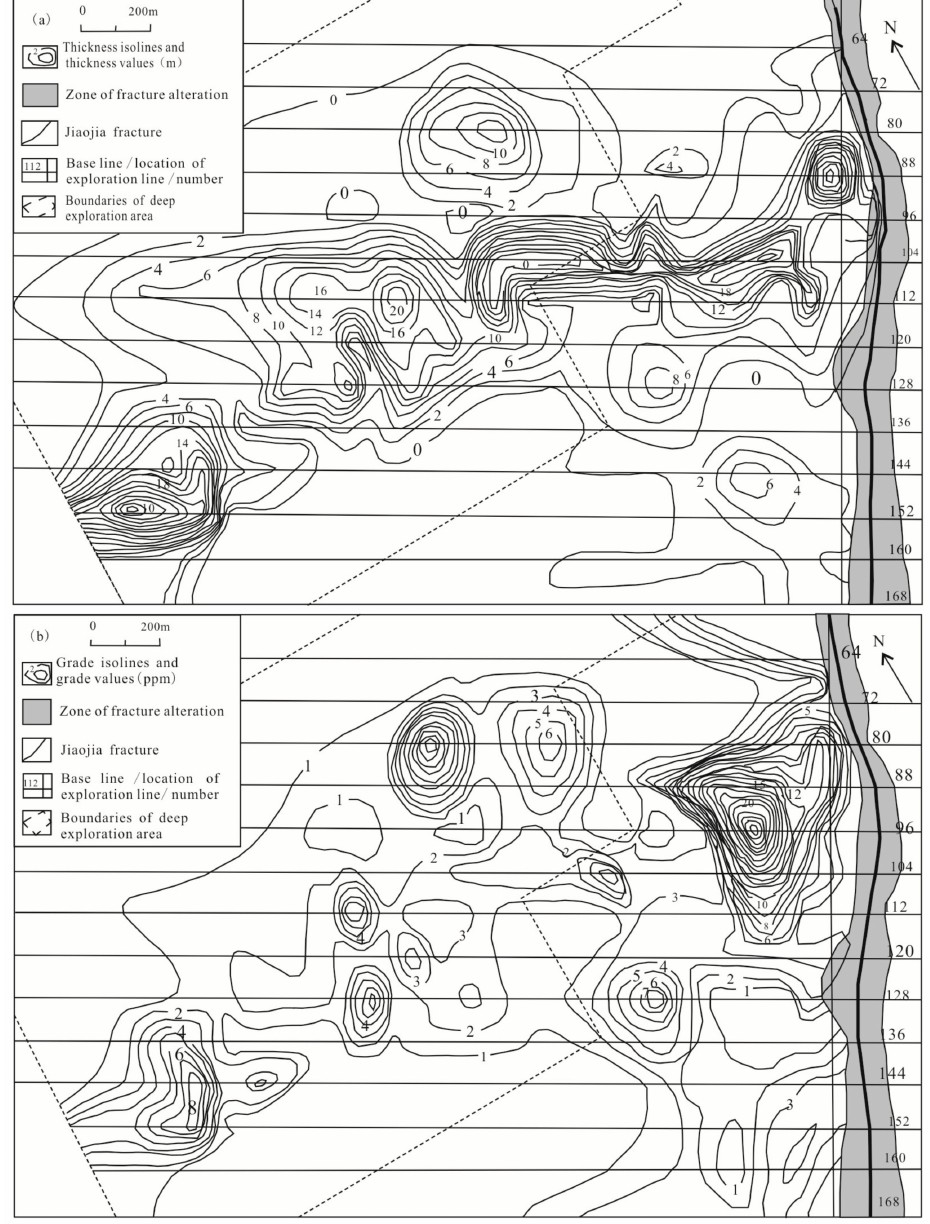
Figure 3. ( a ) Thickness isoline and ( b ) grade isoline of No.1 orebody in the Jiaojia gold deposit (from